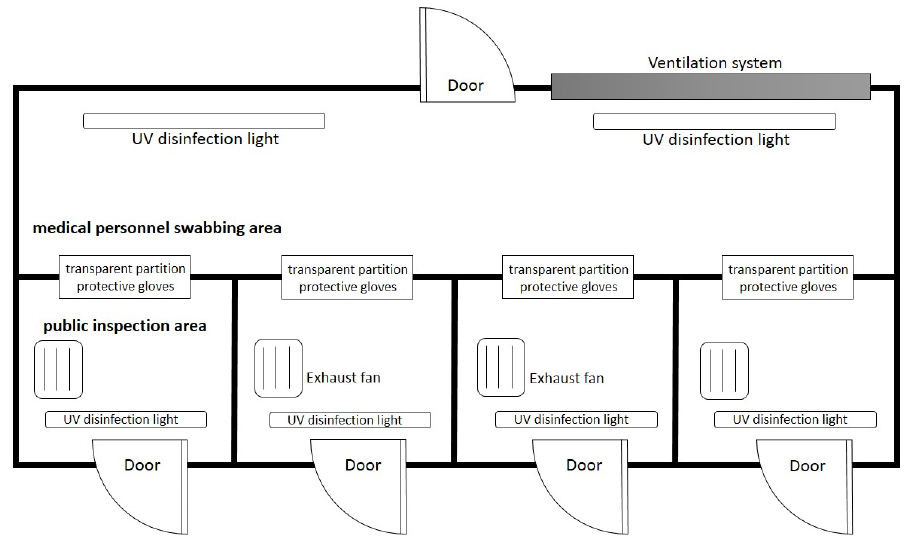
Figure 4. Layout of the positive pressure swabbing room.